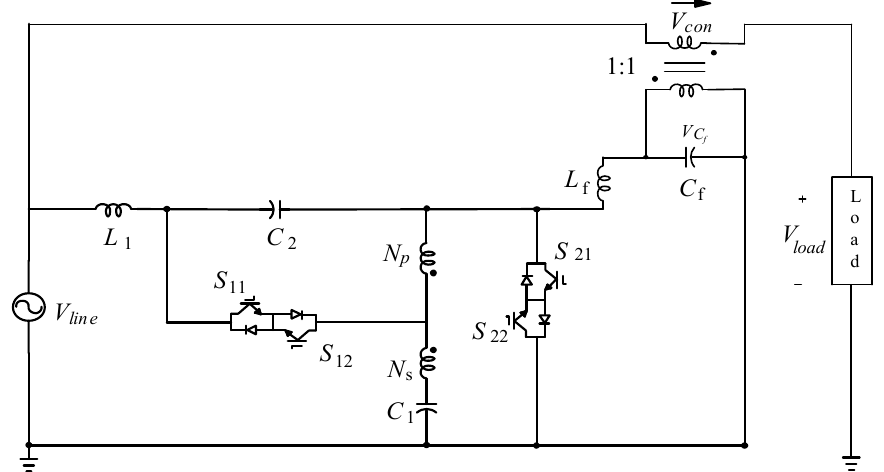
Figure 9. Dynamic voltage restorer based on the proposed converter.